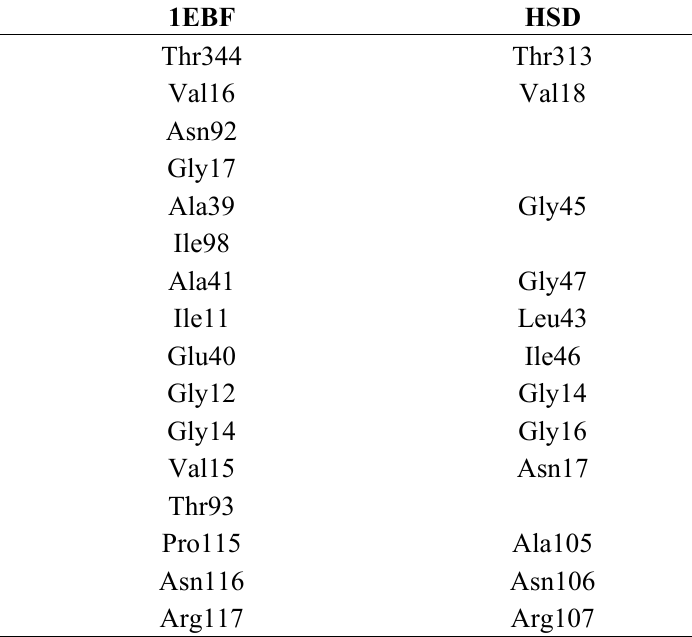
Table 1. The different binding residues between 1EBF and HSD.